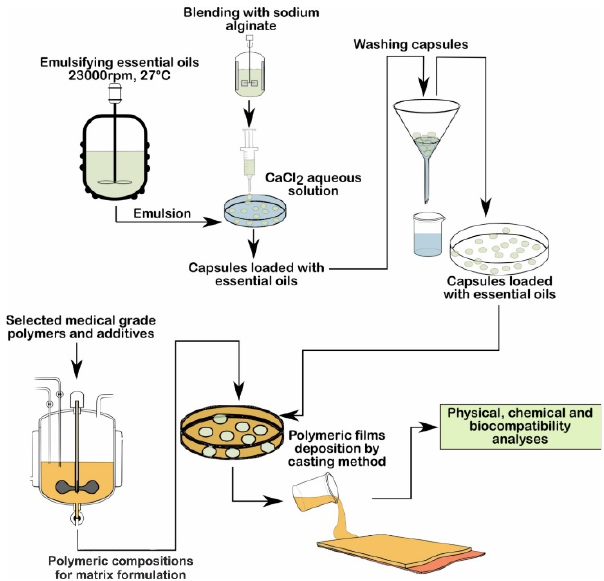
Figure 3. Flow chart of the preparation of samples E1–E8.